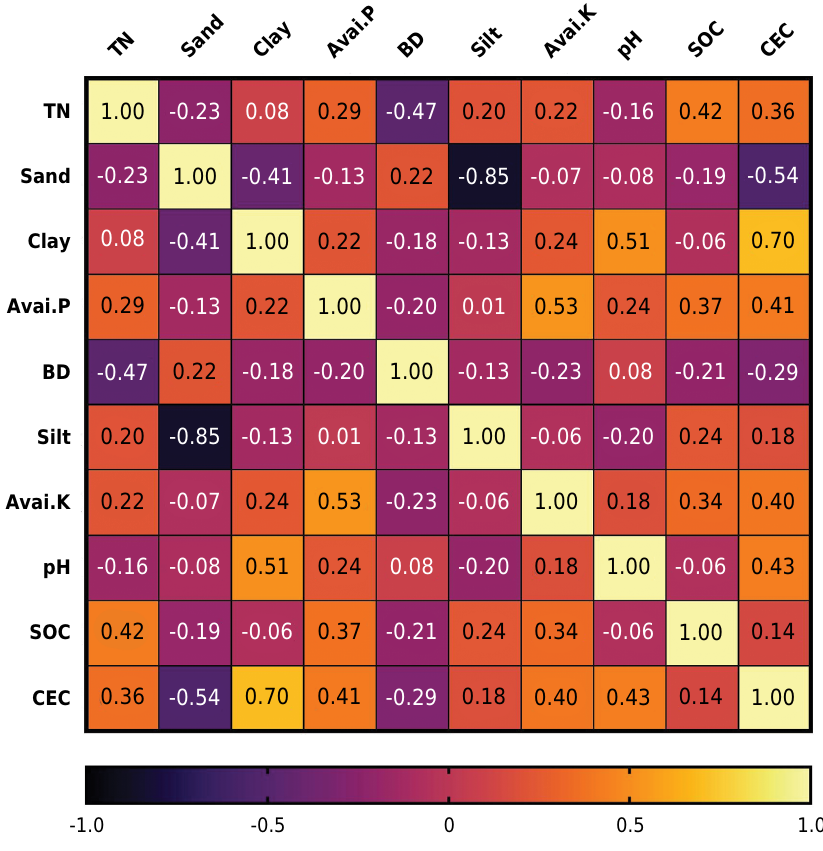
Figure 3. Pearson´s linear correlation coefficients between soil quality indicators.